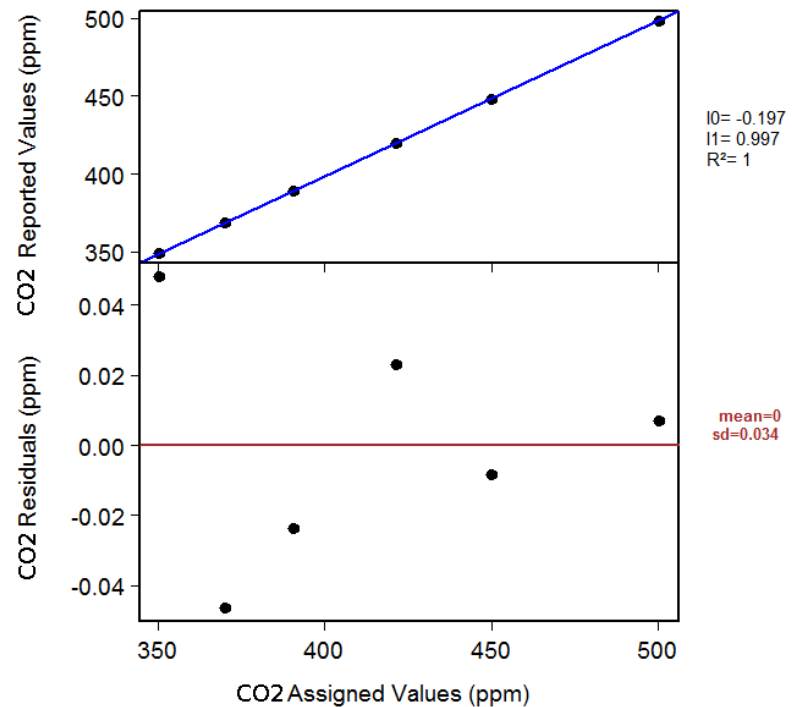
Figure A5. Linearity test for CO 2 . On the top panel, the measured values vs. the assigned values. On the right of this panel, the slope (I1), intercept (I0) and the coefficient of correlation ( R 2 ) are indicated. On the lower panel, the residuals, i.e., the difference between the assigned values and the values calculated using the linear equation, are shown.